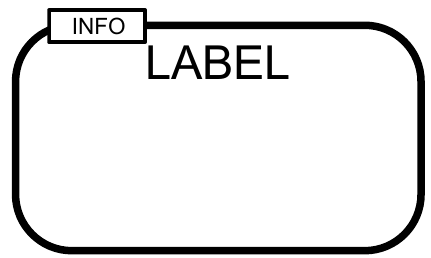
Figure 2.19: The Process Description glyph for compartment